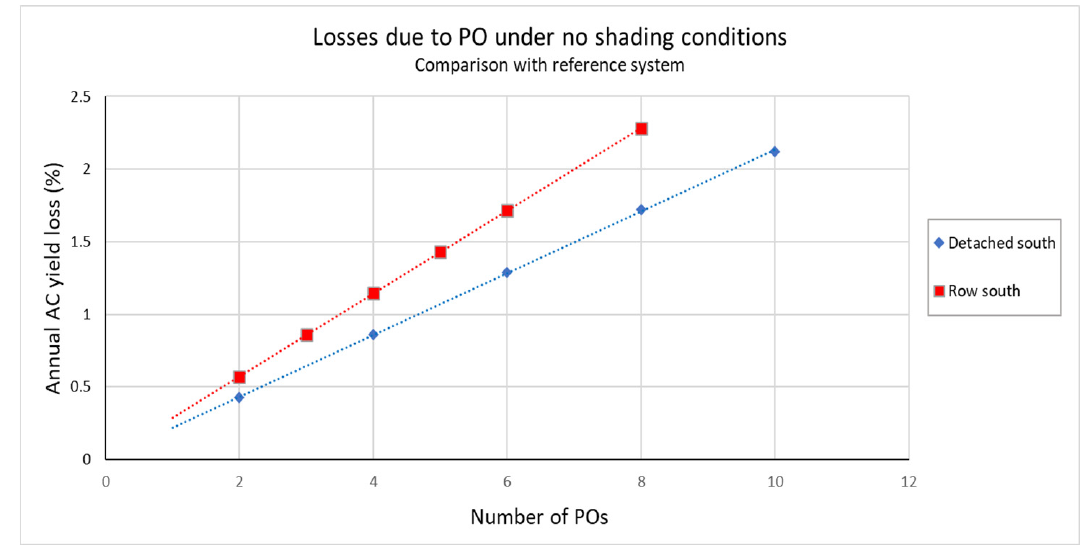
Figure 17. AC yield losses related to SDPO conversion losses in shade-free operation.